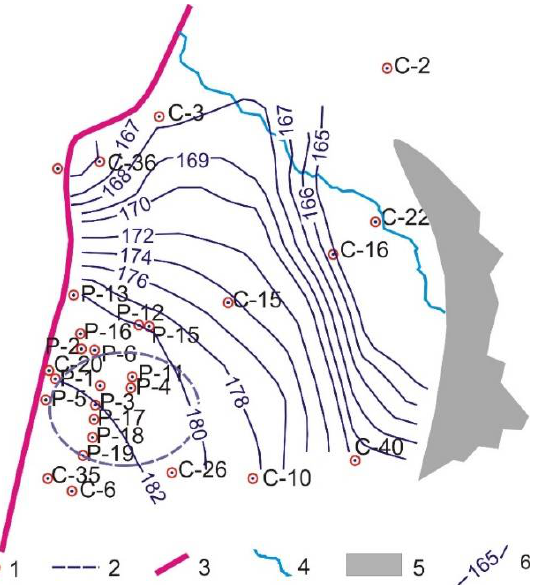
Figure 5. Exploratory borehole locations at the deep injection site of MCP. (1) Boreholes; (2) injection site; (3) right-bank fault; (4) river; (5) zone of wedging out of Horizon I; calculated levels of hydraulic head in Horizon I.